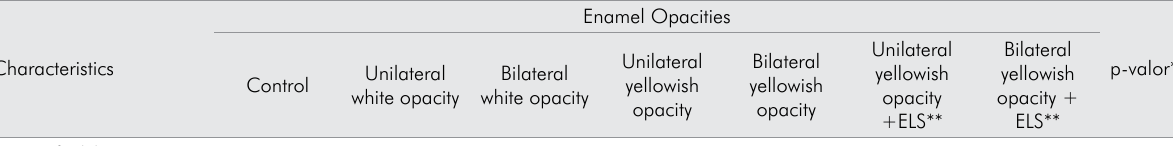
Table 4. Scores (mean ± standard deviation and median ± interquartile range) for positive social judgment according to the individual’s perception of enamel opacities.